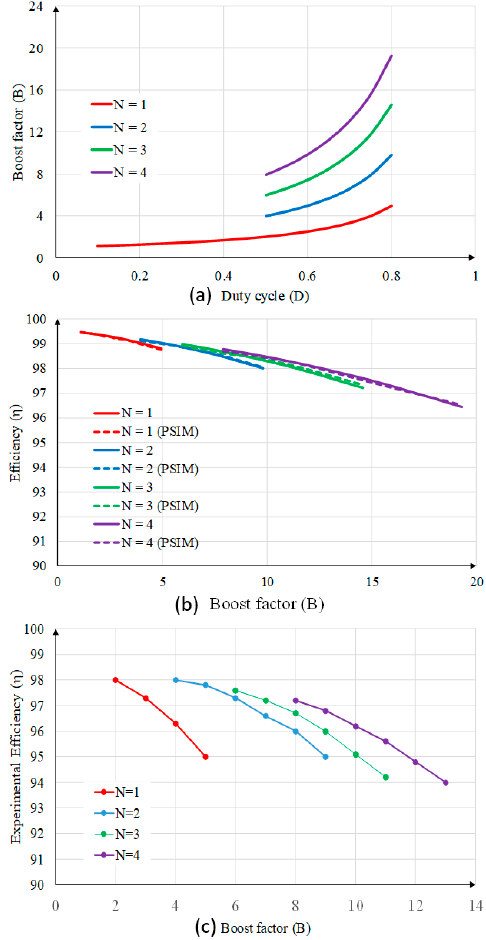
Figure 9. Boost ratio B ( a ), Efficiency η in calculated - simulation ( b ), and experiment ( c ) at Po = 250 W.